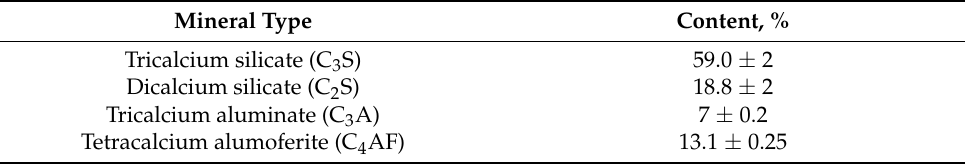
Table 1. Mineralogical composition of the CEM I 42.5 R Portland cement.